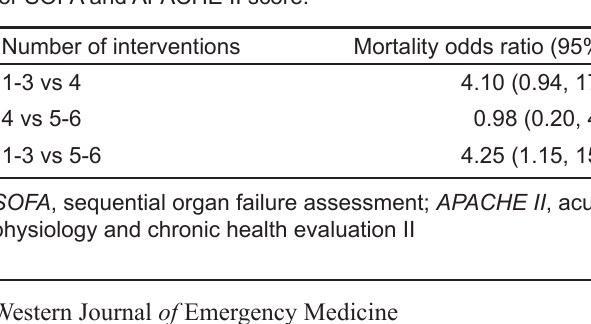
Table 3. Mortality odds ratio by number of interventions adjusted for SOFA and APACHE II score.